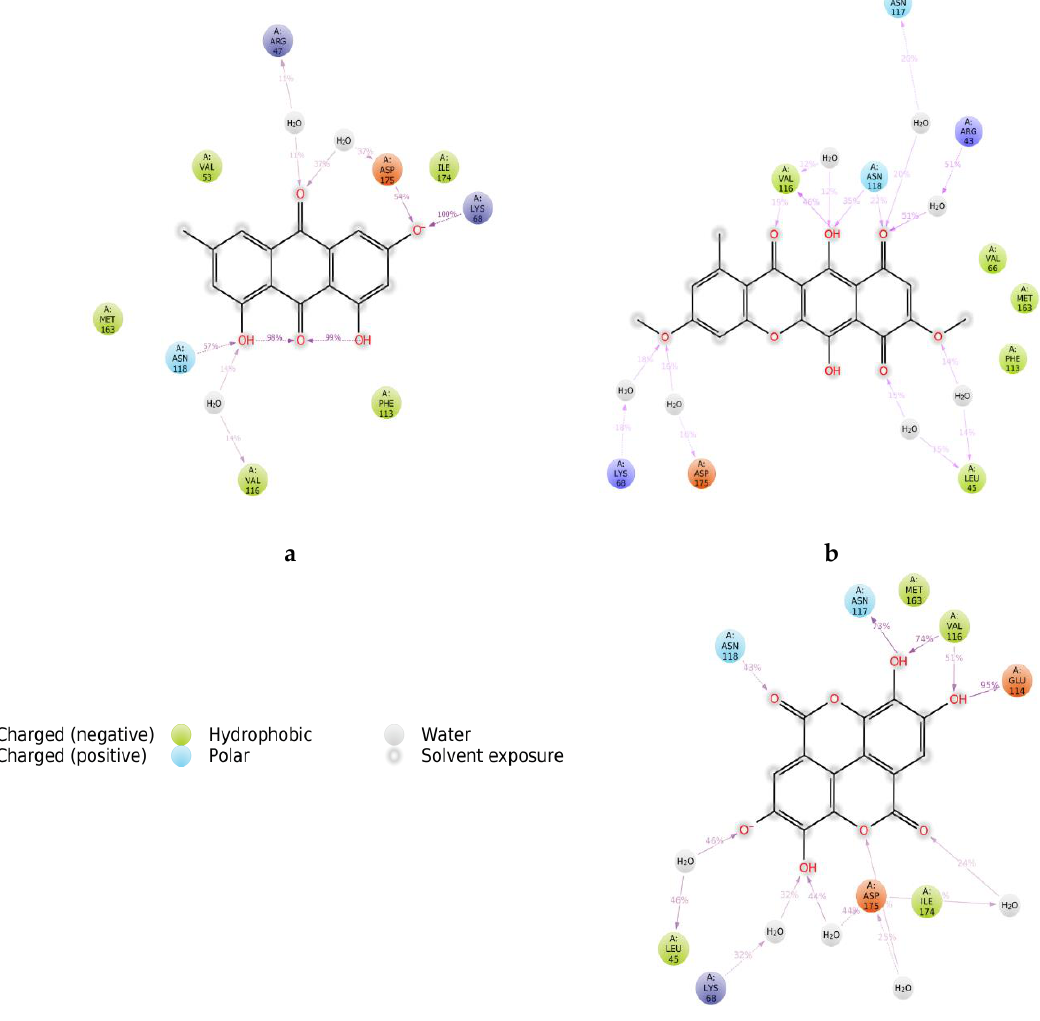
Figure 10. A schematic of detailed ligand atom interactions with the protein residues ( a ) emodin, ( b ) bikaverin and ( c ) ellagic